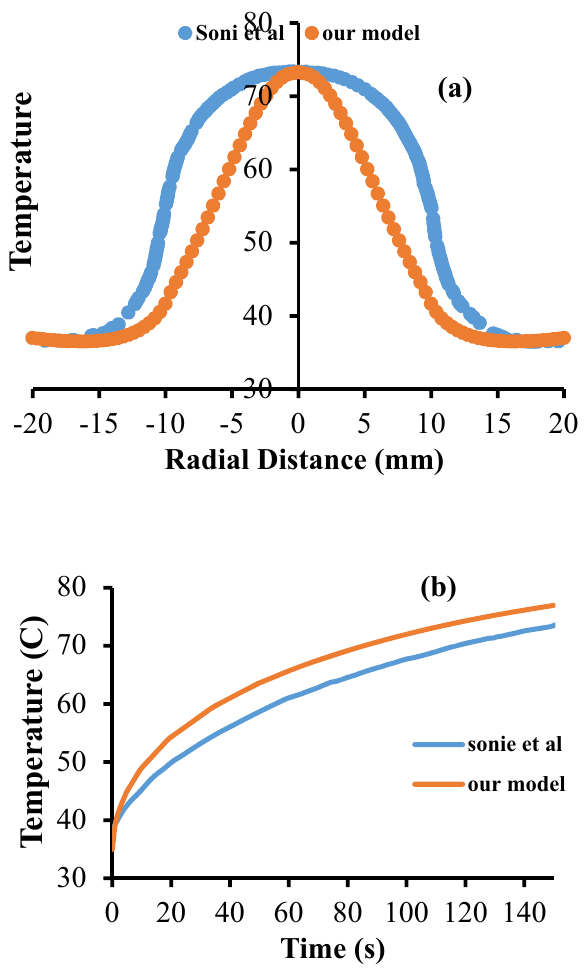
Figure 5. Comparison of the temperature calculated by Sonie et al. 22 and P1-approximation model related to this